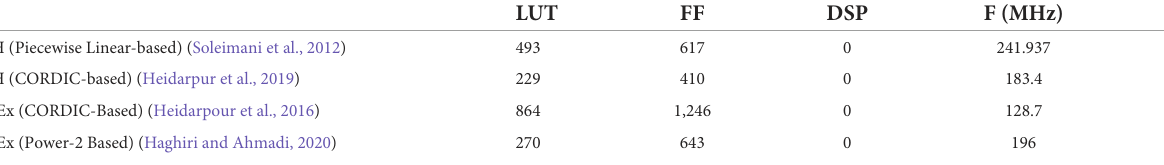
TABLE 2 FPGA resource utilization of the IZH and AdEx